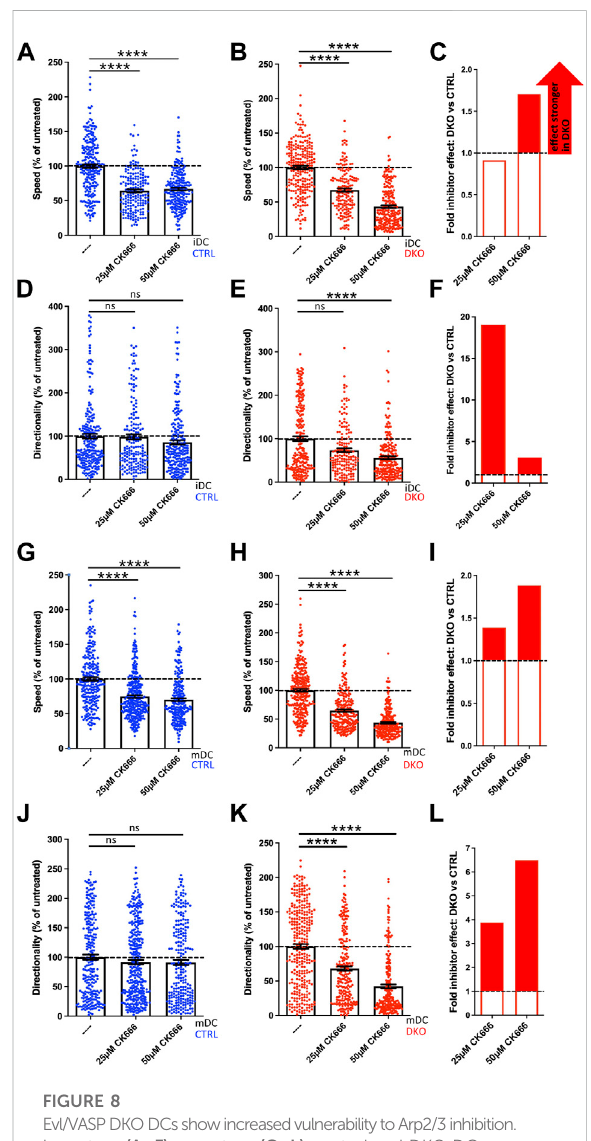
FIGURE 8 Evl/VASPDKODCsshowincreasedvulnerabilitytoArp2/3inhibition. Immature (A – F) or mature (G – L) control and DKO DCs were embedded into 1.9 mg/ml collagen gel. The upper gel surface was covered with medium containing 650 ng/ml CCL19. DCs were either left untreated, or incubated with 25 µM or 50 µM of the Arp2/3 inhibitor CK666 (present in gel and medium). DC migration was monitored by bright- fi eld real-time microscopy for 6 h. Images were obtained at 2 min intervals and analyzed in automated manner. Speed (A,B,G,H) and directionality (D,E,J,K) are depicted as mean ± SEM after normalization to the untreated condition of the respective genotype (N (iDCs) = 161-241 cells from 2 independent experiments; N (mDCs) = 233-337 cells from